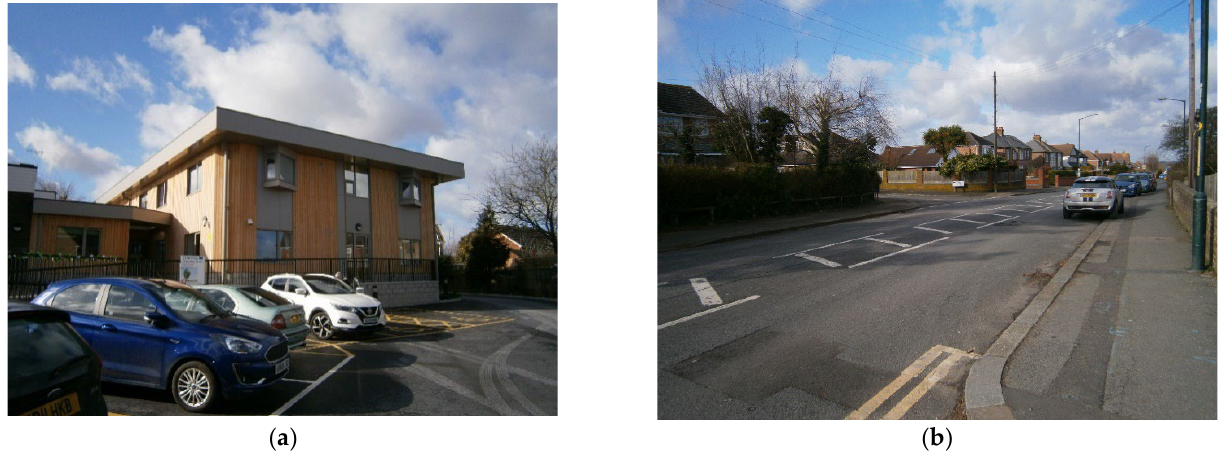
Figure 9. Selection of main pictures of the Harmonia Village project. Source: Own elaboration, 2020. ( a ) The center is in a residential area. Although private vehicles dominate the outdoor spaces, Harmonia House is near several local services that encourages interactions with the surroundings. ( b )